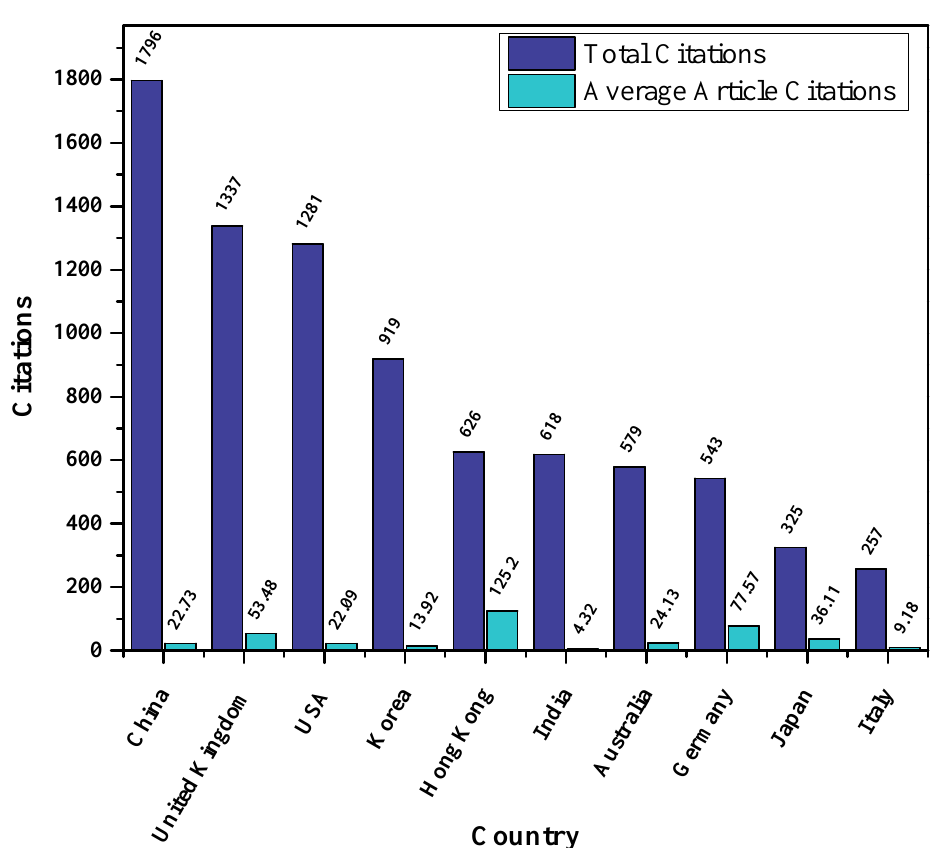
Figure 10. Total and Average articles citations of different